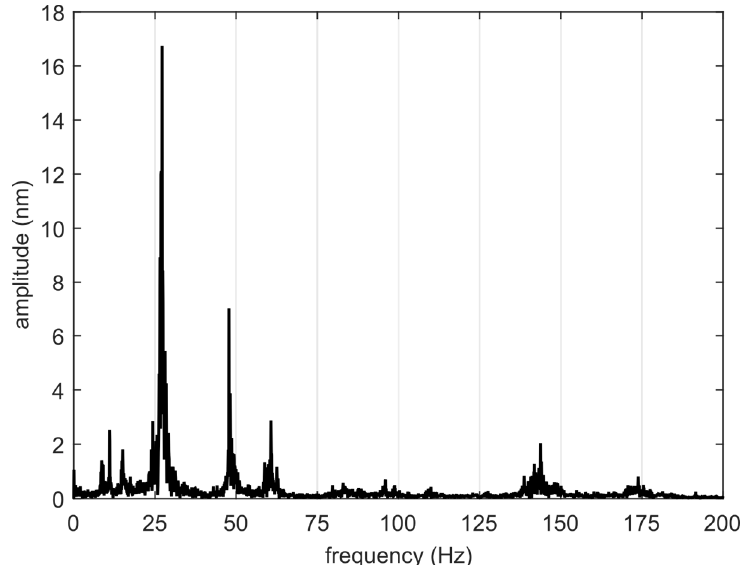
Figure 4. Vibrational spectrum of the SDU displacement. The spectrum was obtained by recording a movie with the WLI camera at a frame rate of 1380 Hz and then making the Fourier transform of the central fringe position.